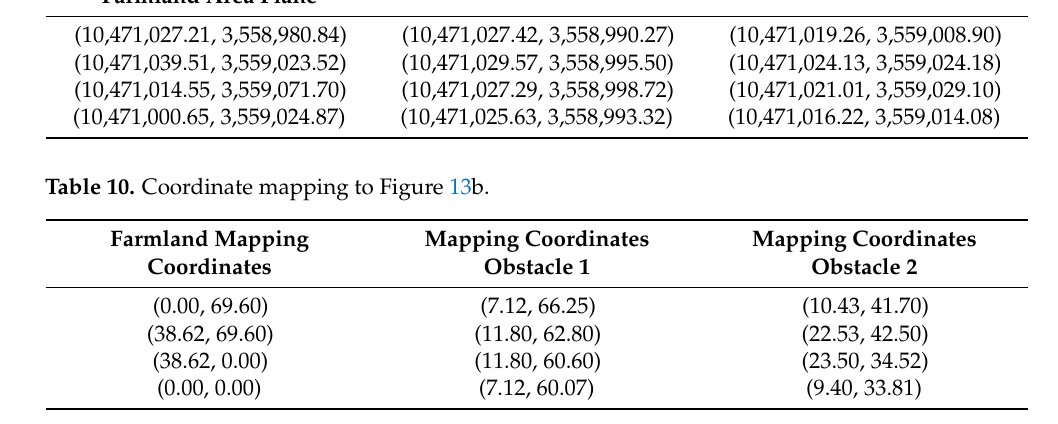
Table 9. Plane coordinates of Figure 13a. Plane Coordinates of Farmland Area Plane